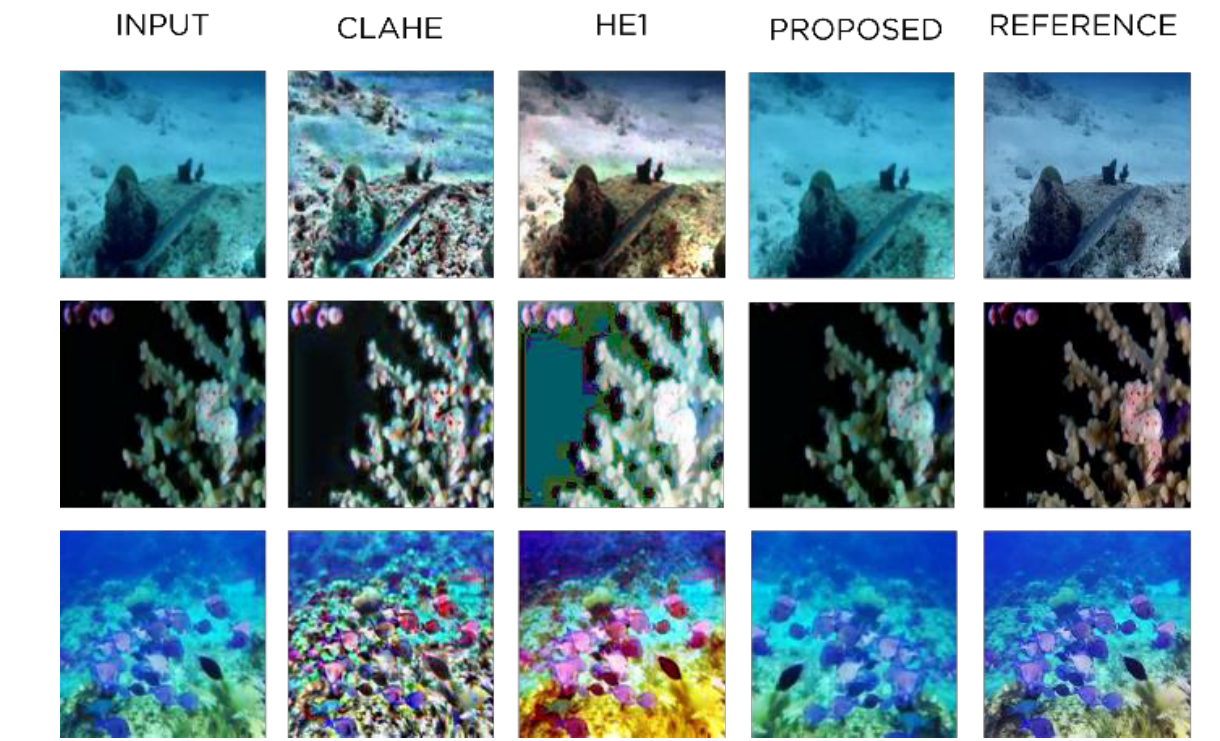
Fig. 5. Subjective Evaluation for the proposed method.